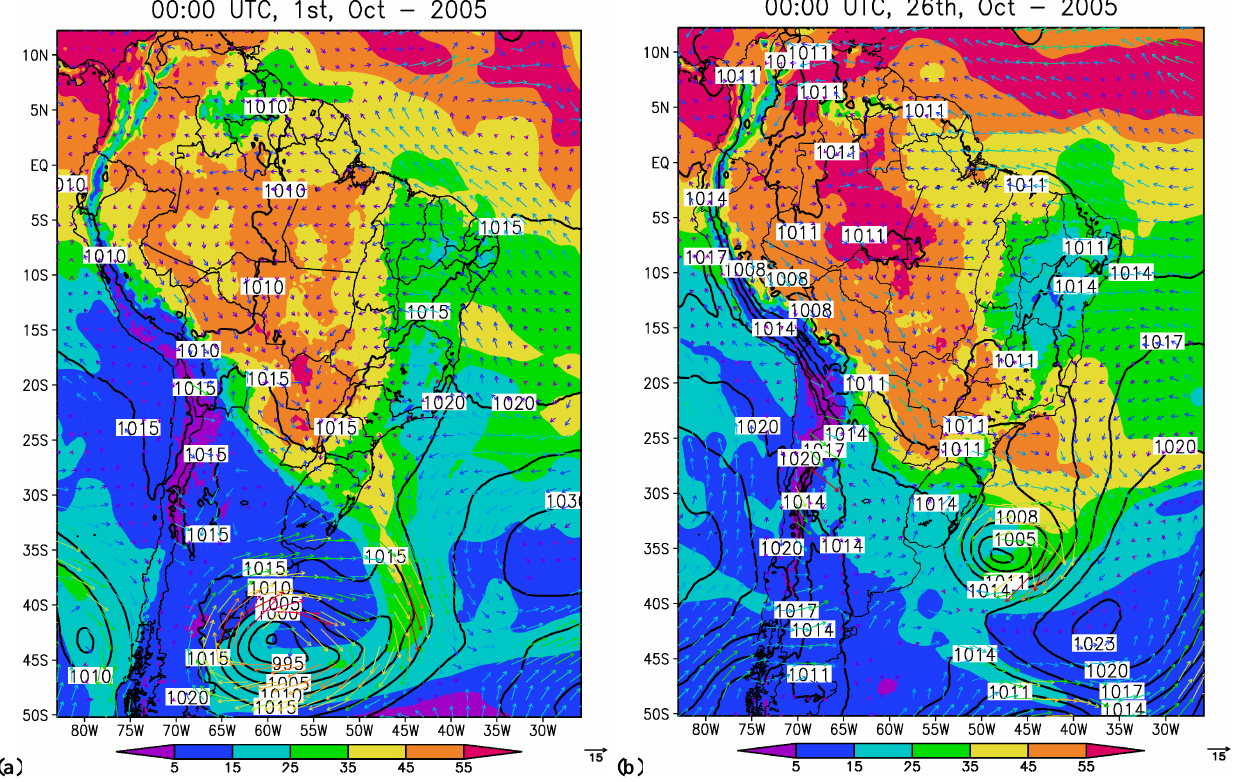
Fig. 1. Sea level pressure (hPa – contour), precipitable water (mm – colored), 850hPa wind (m/s – vector) for 00:00Z, 1 October 2005, on the left (a) , and 00:00Z, 26 October 2005, on the right (b)